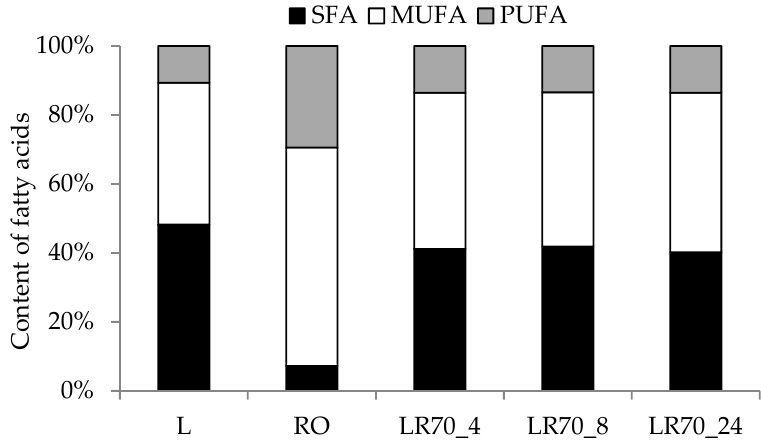
Figure 1. Content (wt%) of the fatty acids (FAs) for raw materials and mixtures after interesterification. The results of the determination of the FA composition of the obtained SL are presented in Table 1 and Figure 1. Mixtures after interesterification showed 13.9% of PUFA, while the Table 1. FAs composition of raw materials and mixtures after interesterification (wt%). original lard only amounted to 10.2% of those acids. TAG of interesterified fats contained 23.2–24.8% of palmitic acid and from 41.8% to 43.4% of oleic acid. The essential FAs